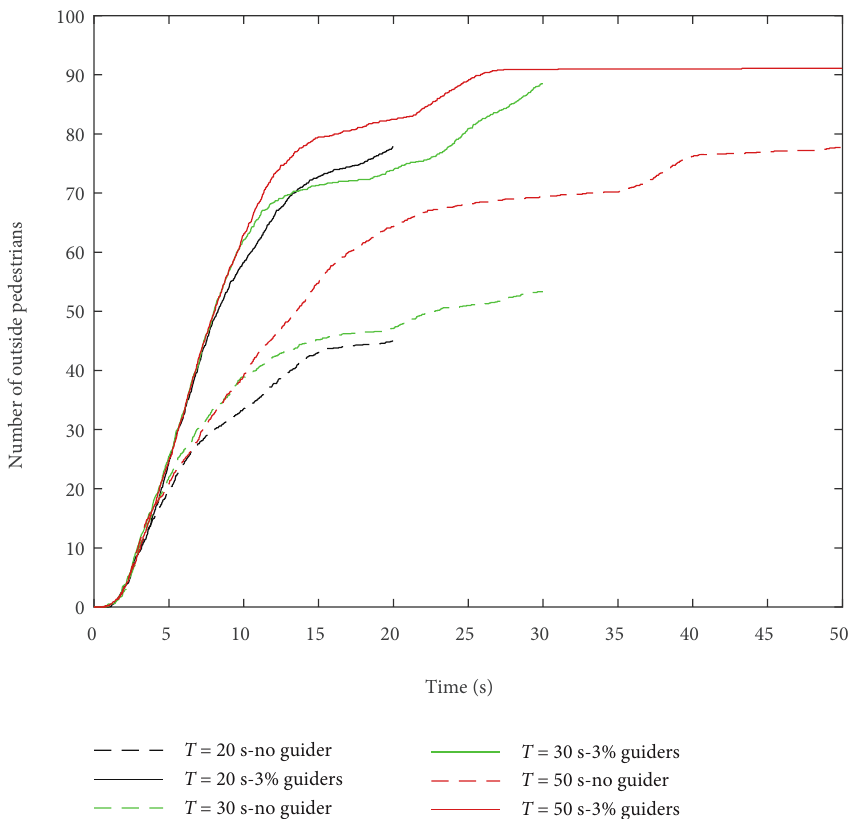
Figure 5: Average number of evacuees of ten trial runs of 100 individuals with 0% and 3% guiders in simulations. Evacuation time periods are set to 20, 30, and 50 s. The simulation domain is a room with two exits as Figure